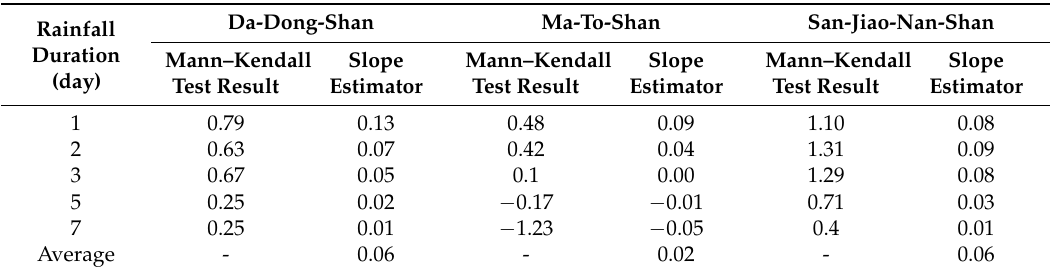
Table 3. Results of trend and slope analysis from 1990–2016.